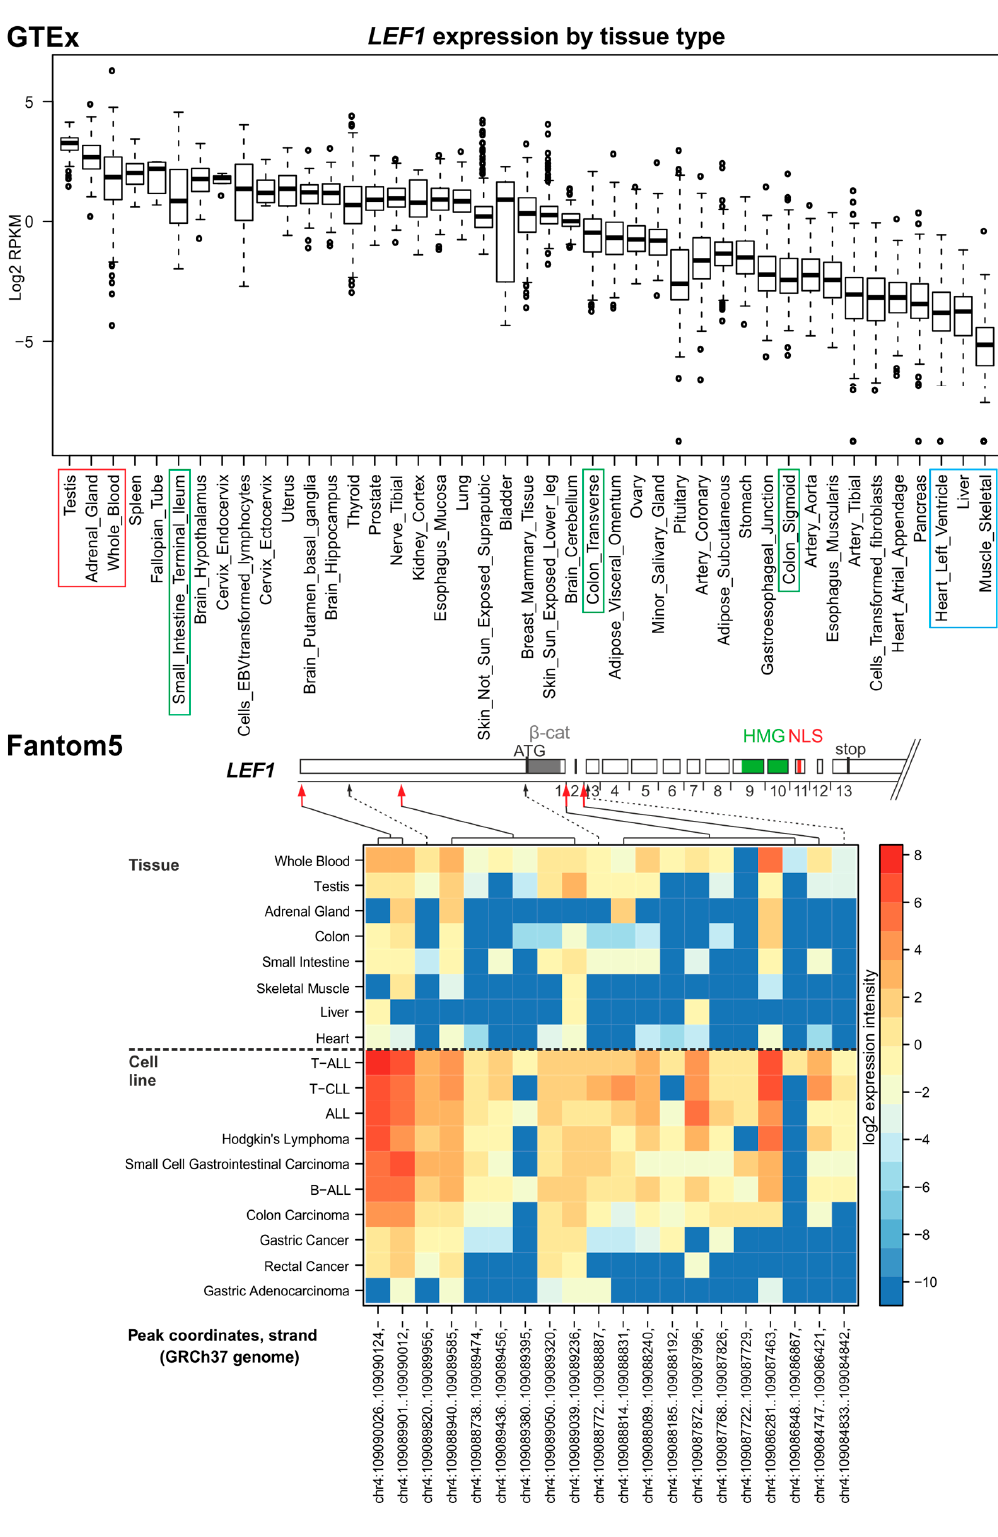
Figure 3. LEF1 expression in human tissues and TSS usage. For description, see Figure 2 legend. ALL, acute lymphoid leukemia; B ‐ ALL, B ‐ cell ALL.